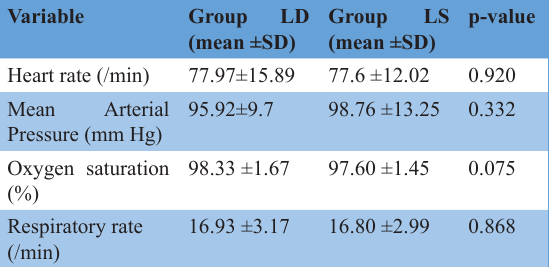
Table 2. Comparison of baseline hemodynamic parameters Variable Group LD Group